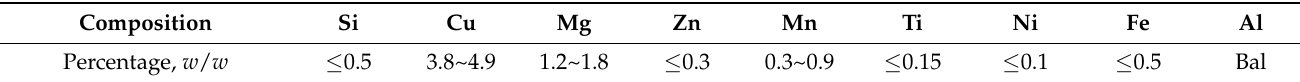
Table 1. Chemical compositions of the 2A12 aluminum.